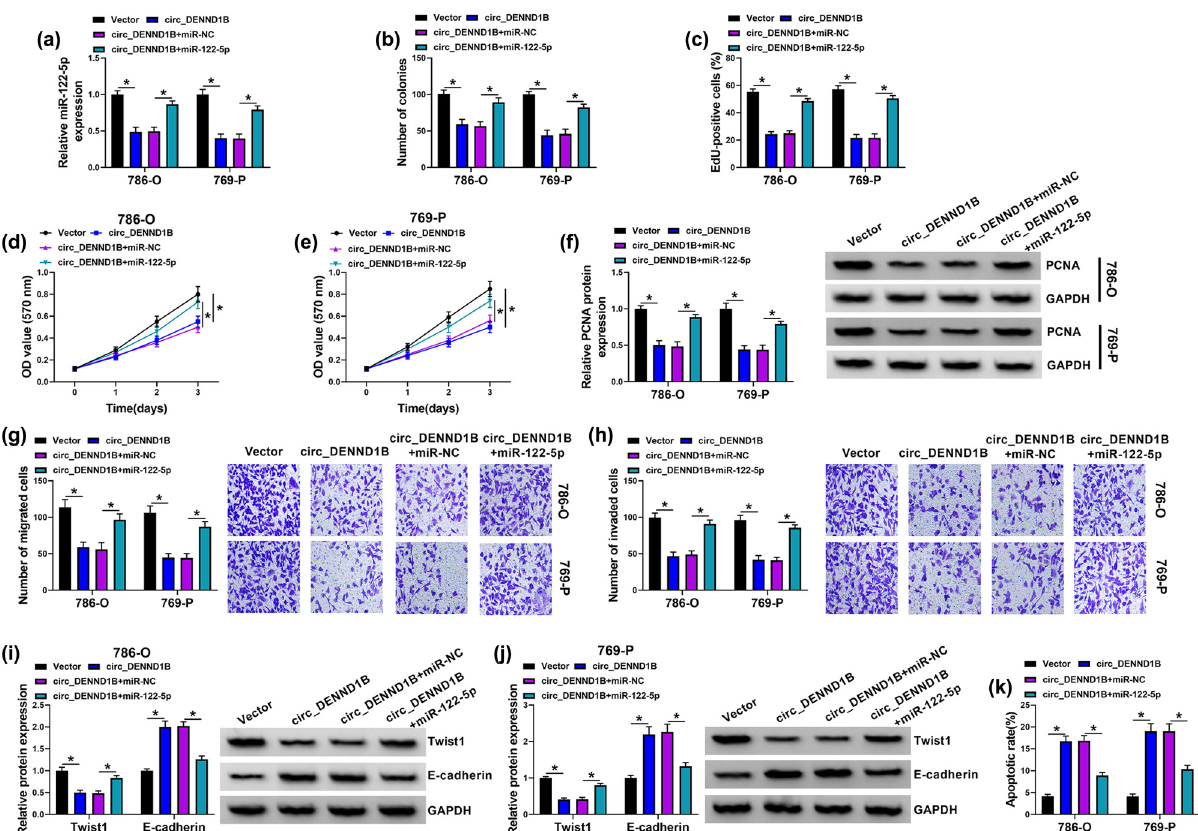
Figure 4: circ_DENND1B/miR - 122 - 5p regulates progress of ccRCC cells. ( a ) qRT - PCR detected the expression of miR - 122 - 5p. ( b ) Colony formation assay detected the number of colonies. ( c ) EdU assay detected the EdU - positive cells. ( d and e ) MTT detected the cell viability. ( f ) Western blot detected the level of PCNA protein. ( g and h ) Transwell assay detected the cell migration and invasion ability. ( i and j ) Western blot detected the level of Twist1 and E - cadherin. ( k ) Cell apoptosis was detected by fl ow cytometry. * P <